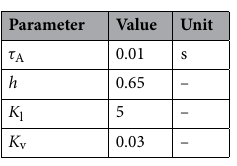
Table 2. Muscle and reflex parameters.